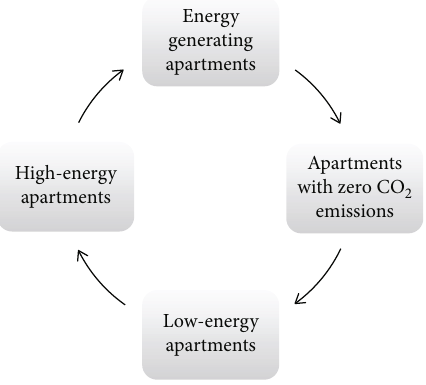
Figure 2: Di ff erent types of